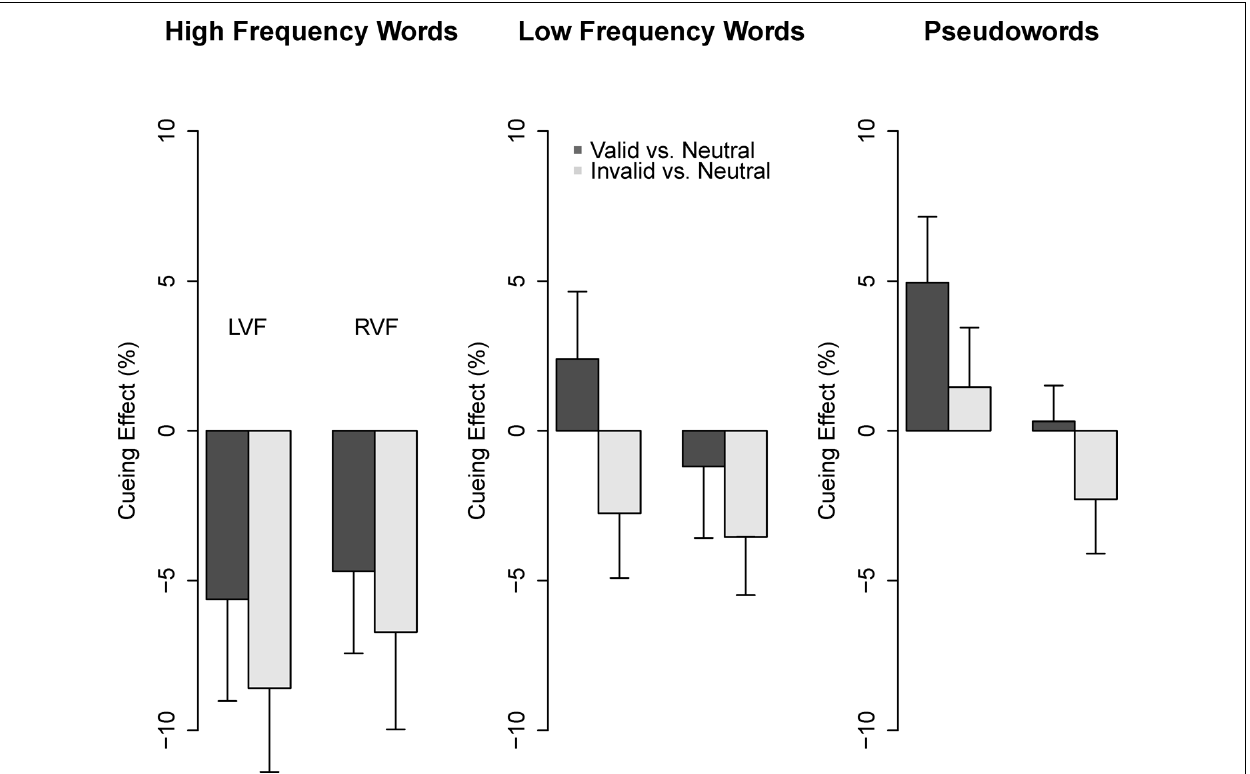
FIGURE 3 | Cueing effect (in percentage) for the three types of string, using neutral condition as baseline. This was computed as difference between valid and neutral condition (dark gray), and difference between invalid and neutral condition (light gray). LVF, left visual field; RVF, right visual field. Error bars represent